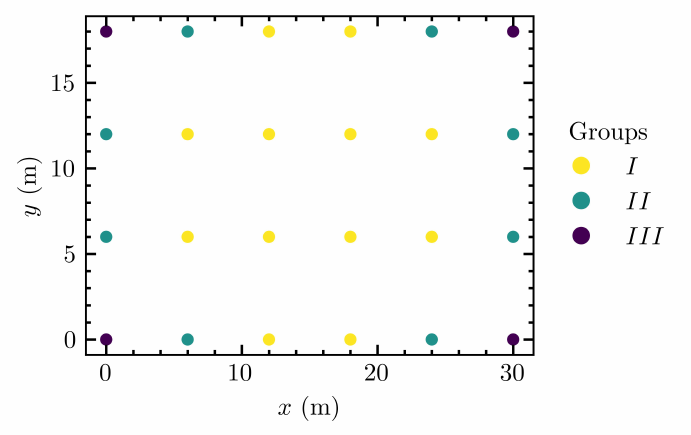
Figure 8. Equivalent boreholes for a field of 24